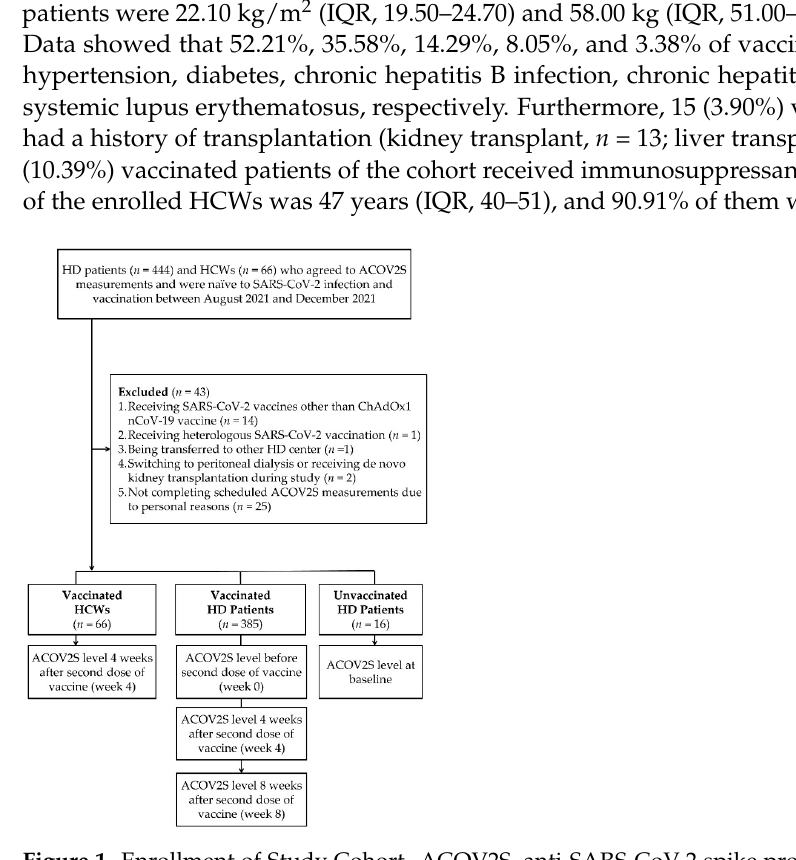
Figure 1. Enrollment of Study Cohort. ACOV2S, anti-SARS-CoV-2 spike protein antibody; HCW, healthcare worker; HD, hemodialysis; n, number; SARS-CoV-2, severe acute respiratory syndrome coronavirus 2. Table 1. Characteristics of HD Patients ( n = 385) Receiving ChAdOx1 nCoV-19 Vaccine.